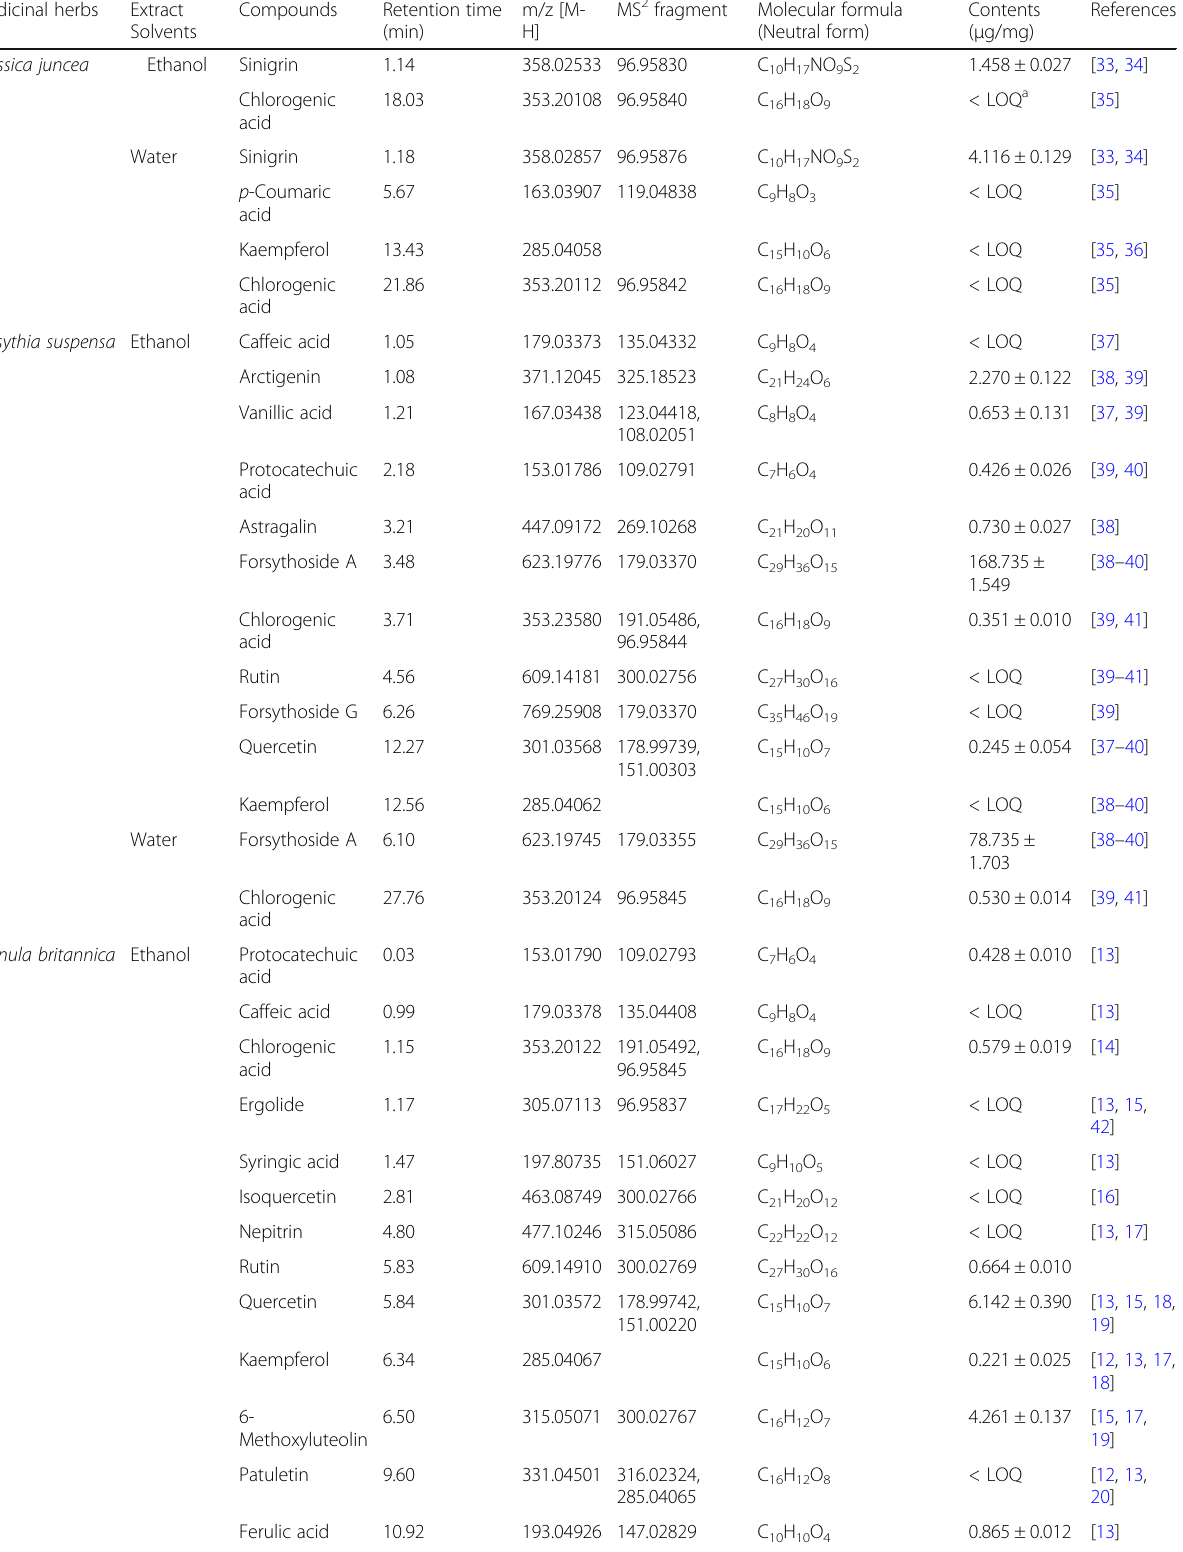
Table 2 Ultra performance liquid chromatography (UPLC)-electrospray ionization (ESI)-Q/Orbitrap tandem mass analysis of medicinal herbs Medicinal